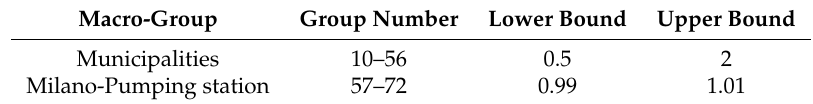
Table 3. Upper and lower variability bounds for the two well macro-groups defined.